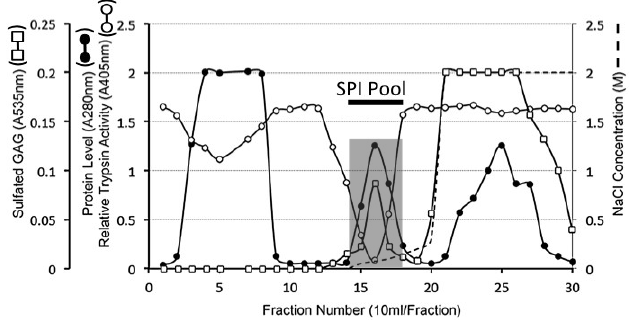
Figure 1. Diethylaminoethyl (DEAE) Anion exchange chromatography of a 6 M urea extract of ovine articular cartilage showing protein (A280 nm), sulfated glycosaminoglycan (A535 nm), and relative trypsin inhibitory activity of the fractions (A405 nm). The column was eluted with a gradient of NaCl (dotted line). Fractions displaying serine proteinase inhibitor (SPI) activity were pooled as shown for further purification.